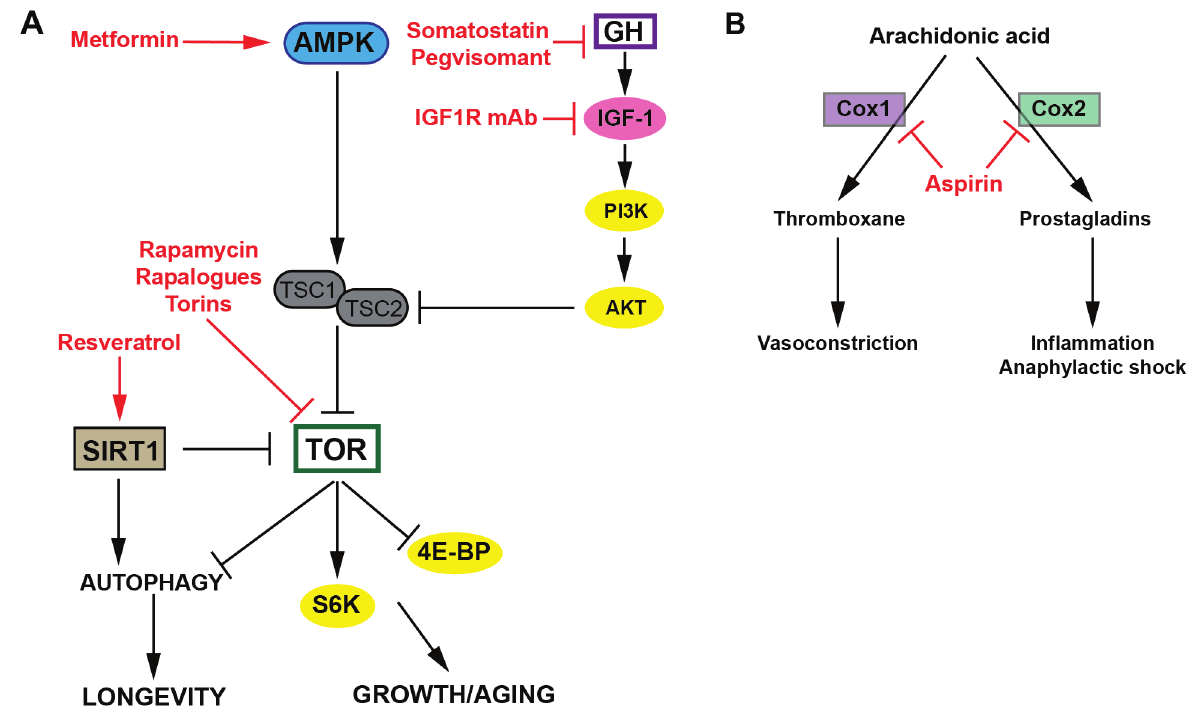
Figure 1: Overview of the signaling pathways controlling cellular growth, metabolism and affecting aging, and some of the drugs mentioned in the manuscript. A. Relationships between IGF/GH axis, TOR and AMPK pathways and sirtuins in aging and lifespan regulation and drugs that either inhibit or boost their functions (look inside text for details). B. General scheme for the inhibitory action of aspirin on COX1 and COX2 leading to beneficial cellular and organismal